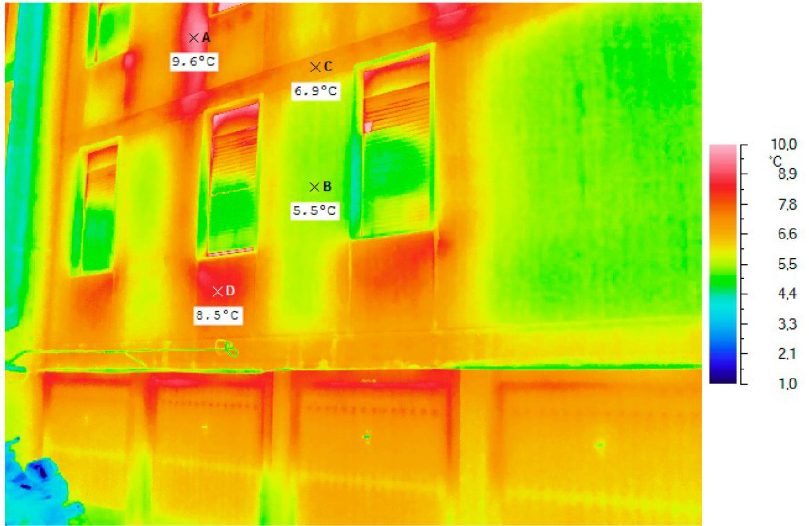
Figure 6. Thermal imaging survey on the north-east façade before retrofitting.